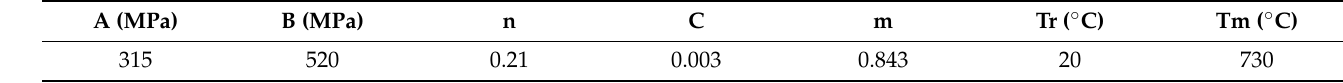
Table 4. Model parameters of the composite materials.